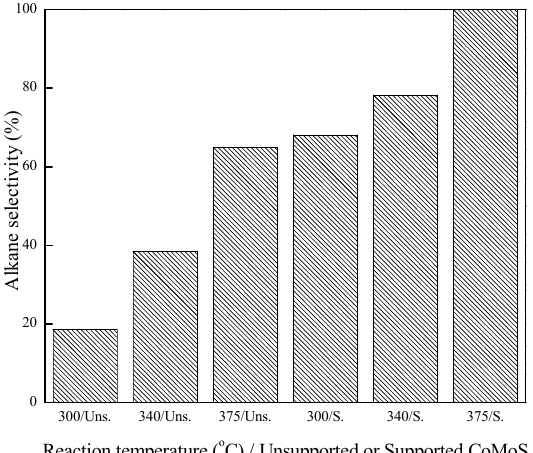
Figure 7. Hydrogenation or dehydrogenation reactions during WCO hydrotreating processes.